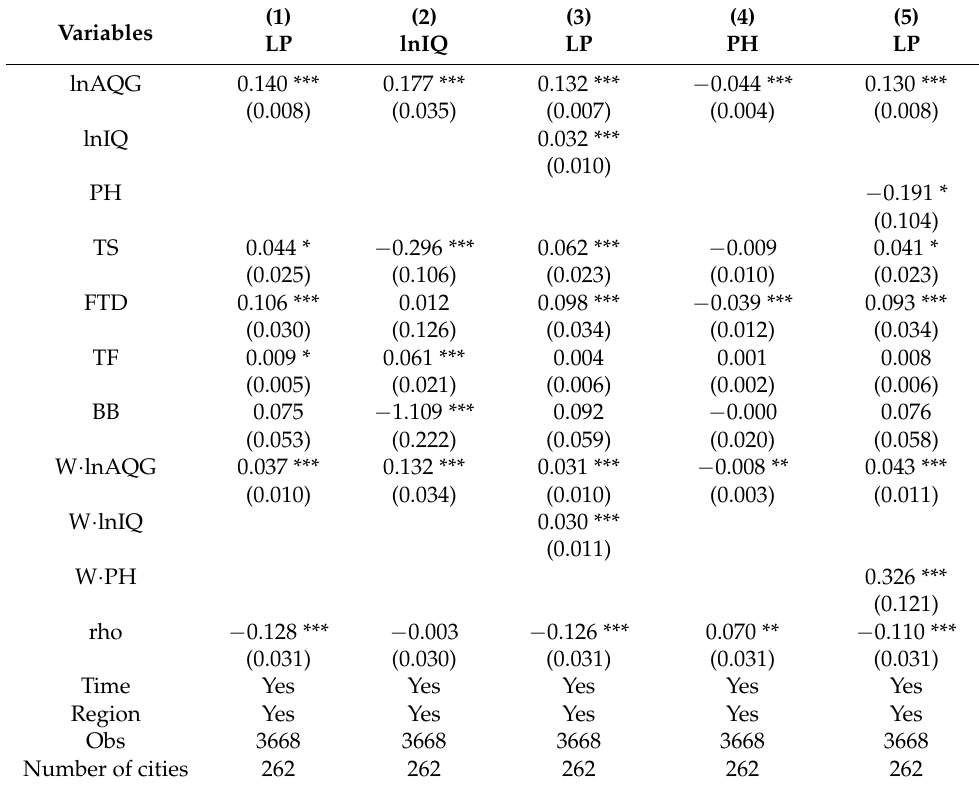
Table 15. Air pollution governance and labor productivity: a mediating effect